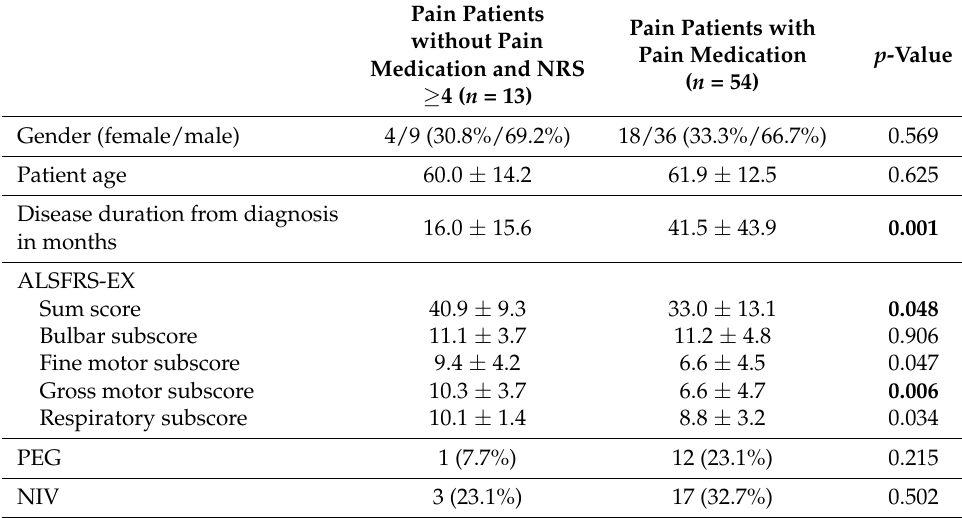
Table 4. Demographic and clinical data of the ALS patients without pain medication and at least moderate pain (NRS ≥ 4) compared to those patients with pain medication (mean ± SD or number of patients (%), as